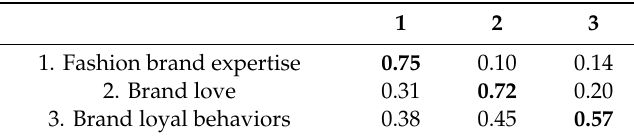
Table 3. AVEs, correlations, and squared